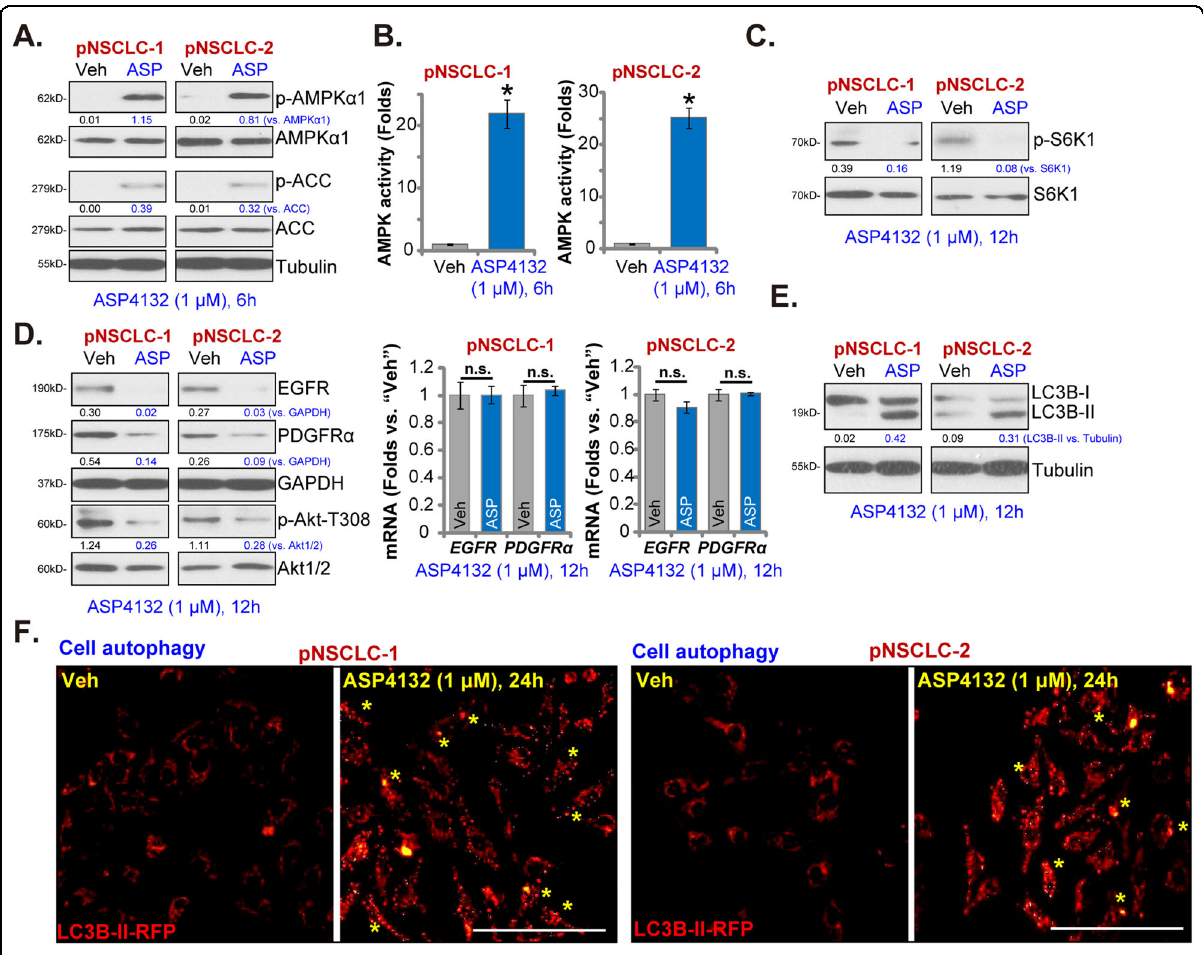
Fig. 4 ASP4132 activates AMPK signaling in NSCLC cells. Primary NSCLC cells, pNSCLC-1/-2, were treated with ASP4132 (1 μ M) or the vehicle control, cells were further cultured for applied time periods, expression of listed proteins in total cell lysates was tested by Western blotting assays ( A , C , D , E ); The relative AMPK activity was tested as well ( B ). List mRNAs were tested by qPCR assays ( D ). LC3B-II RFP (red fl uorescence protein) puncta was examined ( F ). Expression of listed proteins was quanti fi ed and normalized to the loading control ( A , C – E ). “ Veh ” stands for the vehicle control (Saline). Data were presented as mean ± standard deviation (SD, n = 5). * p < 0.05 vs. “ Veh ” cells. “ n.s. ” stands for no statistical difference ( D ). The experiments were repeated fi ve times with similar results detected. Scale bar = 100 μ m ( F